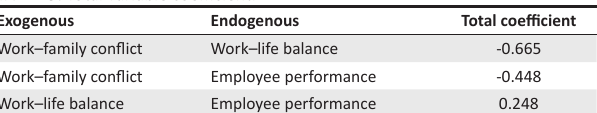
TABLE 9: Total variable coefficient.